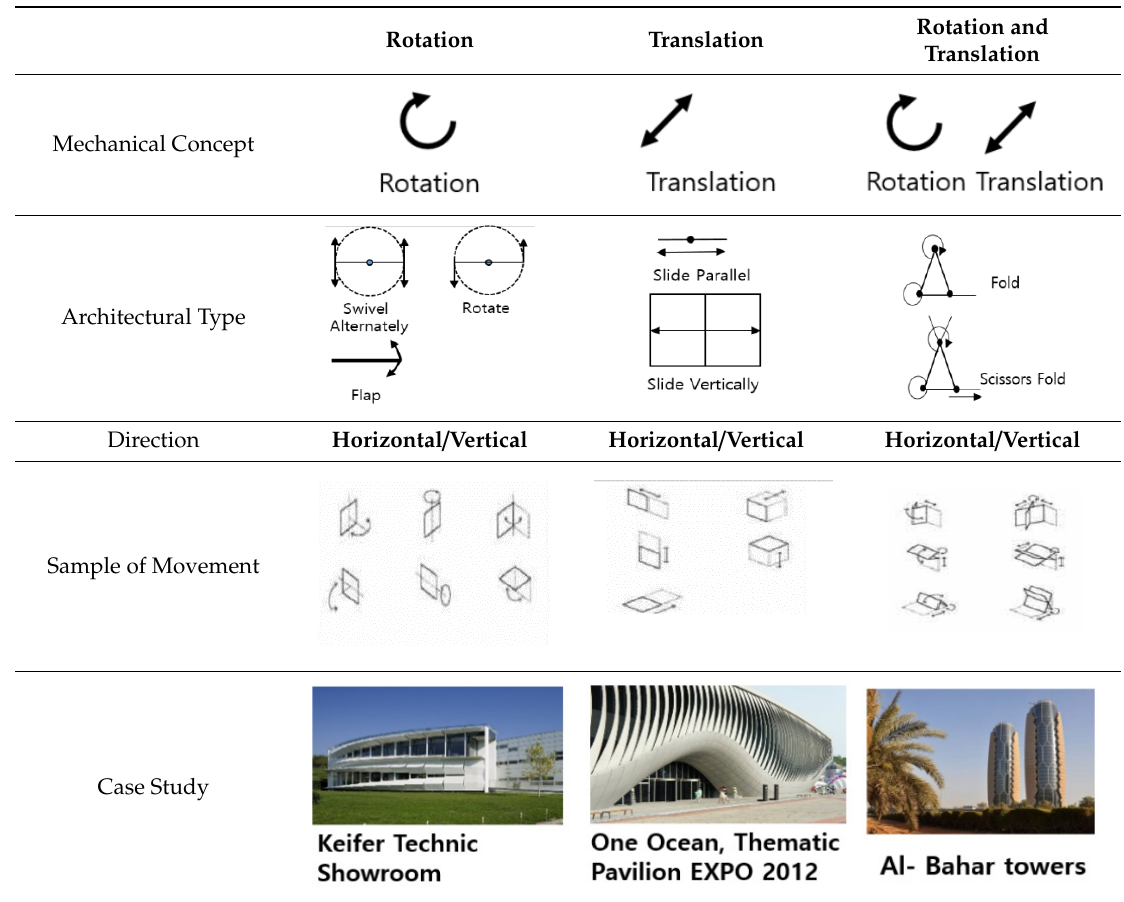
Table 2. Typology of Motion in Facades and Case Studies.